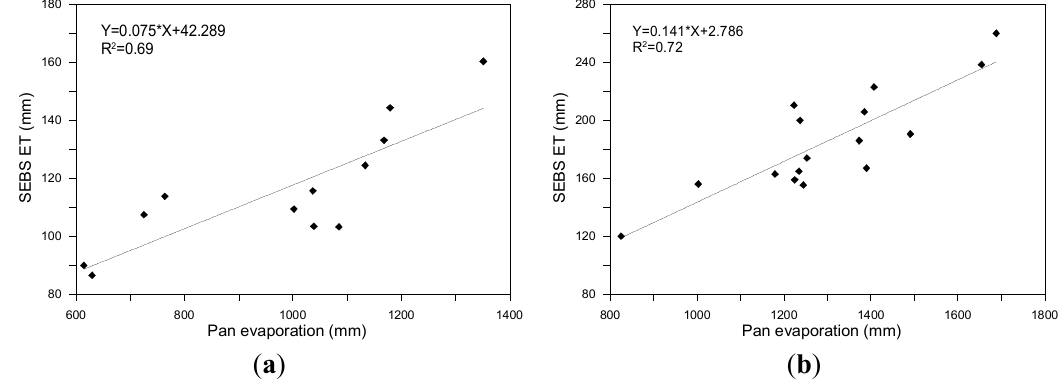
estimates and observed pan evaporation in Figure 5. Correlation between SEBS ET a ( a ) MLH, YCD and WTM sub-regions (west areas) and ( b ) QDL, DXS, BDL, GLM sub-regions (east areas) of Qaidam